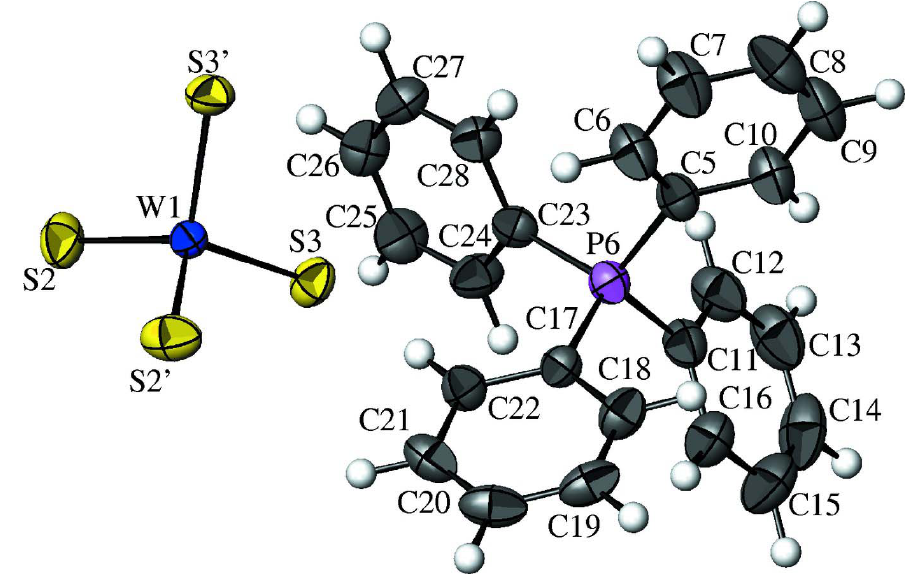
Figure 1 Local coordination diagram for [Ph probability for non-H atoms. H atoms are shown as circles of arbitrary radii. [Symmetry code: (i) - x , y , 3/2 - z ]